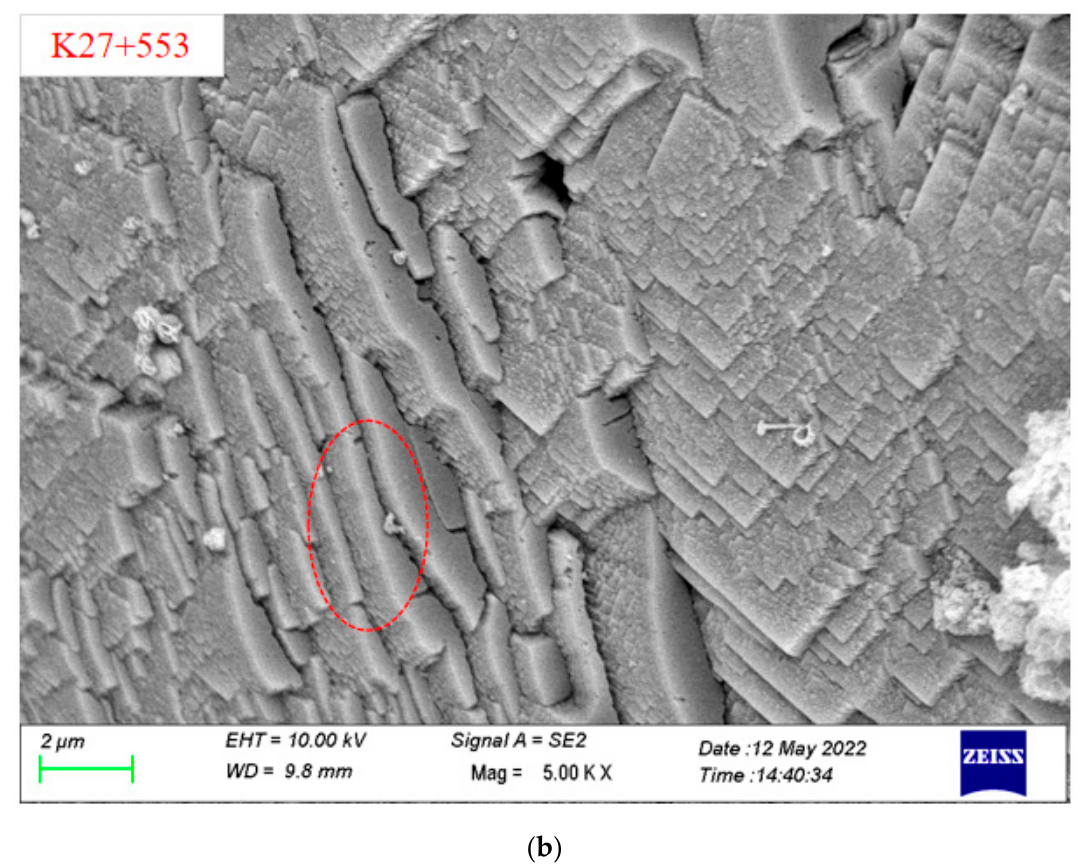
Figure 4. XRD diffraction pattern and micro morphology of crystal. ( a ) XRD diffraction pattern; ( b ) micro morphology of crystal.